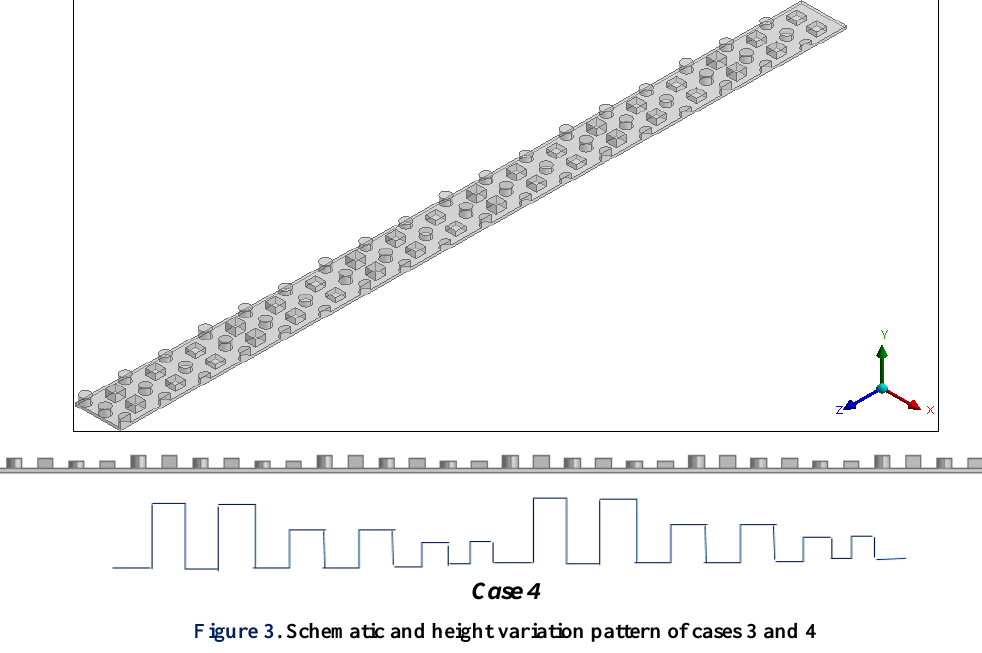
Figure 3. Schematic and height variation pattern of cases 3 and 4 Table 1. The main properties of the battery cell [12] Parameter Value Active area dimension (mm)